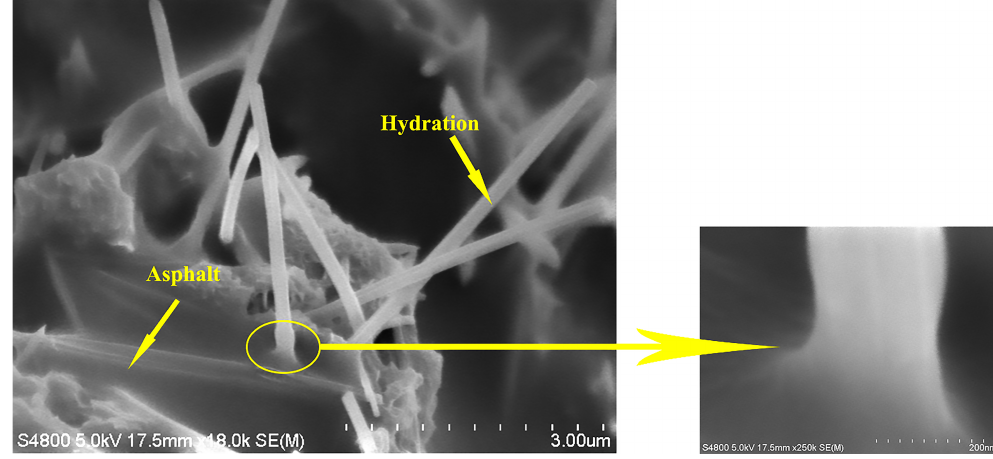
Figure 6. The adhesive state between asphalt membrane and hydration